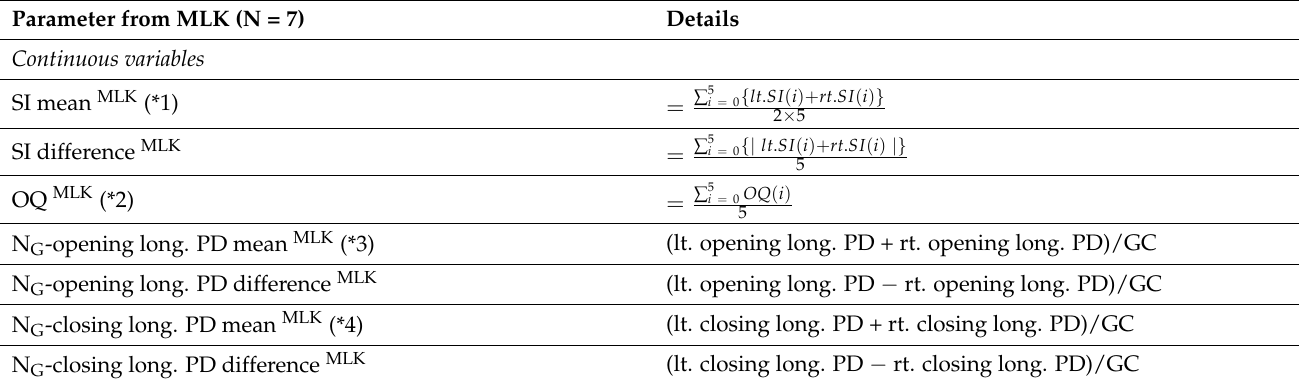
Table 5. Parameters from digital kymography (DKG) 2: Multi-line kymography (MLK).